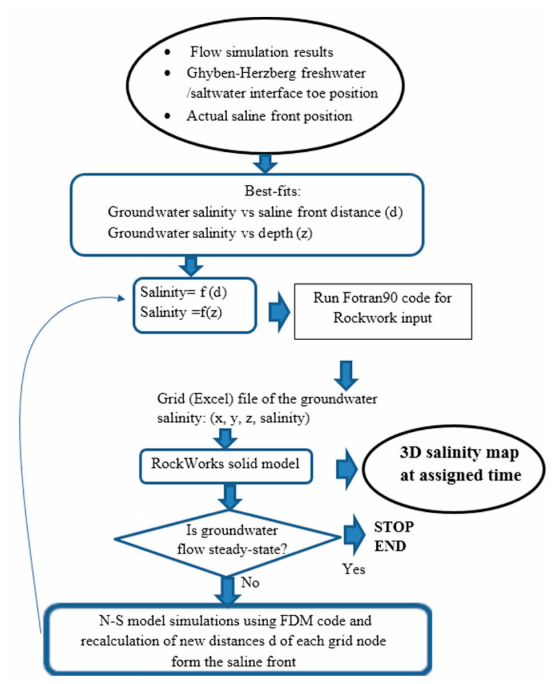
Figure 2. Flowchart of the applied methodology to produce transient 3D maps of the groundwater